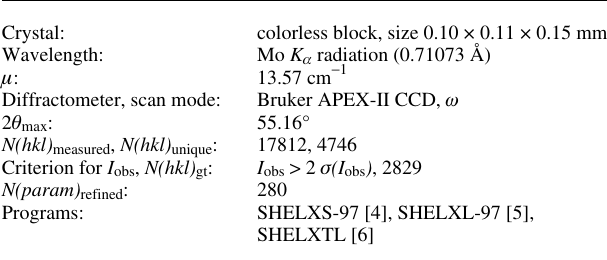
Table 1. Data collection and handling.